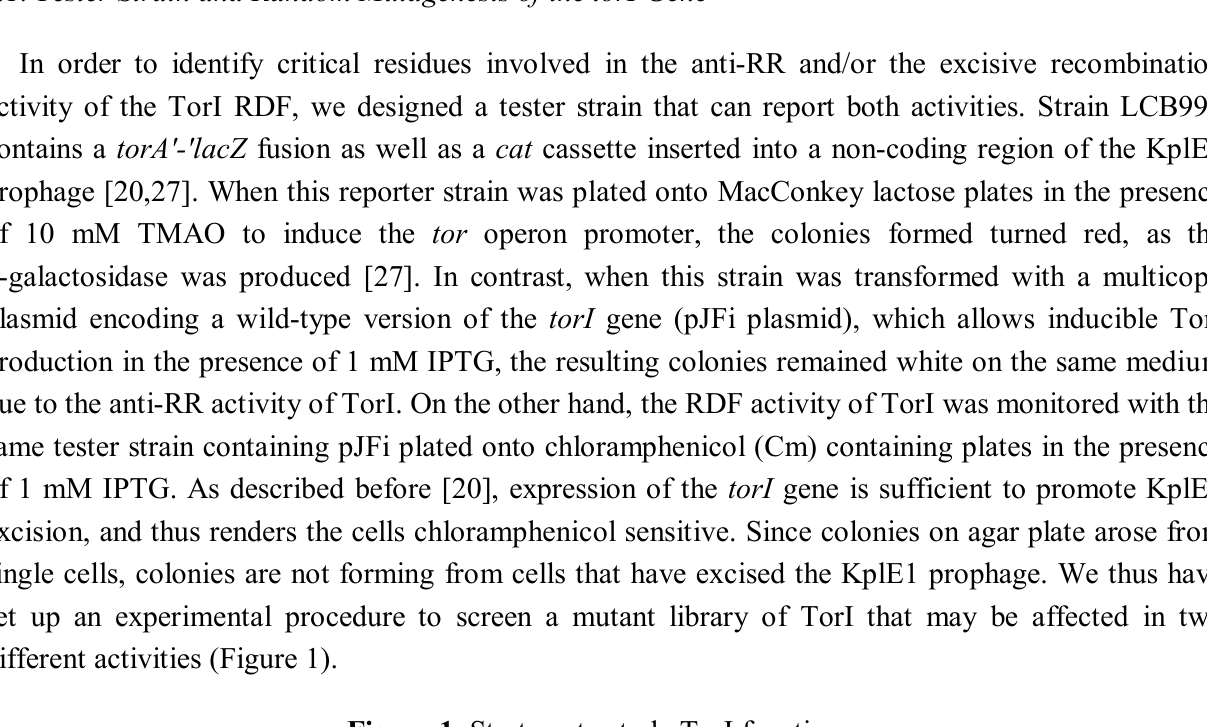
Figure 1. Strategy to study TorI